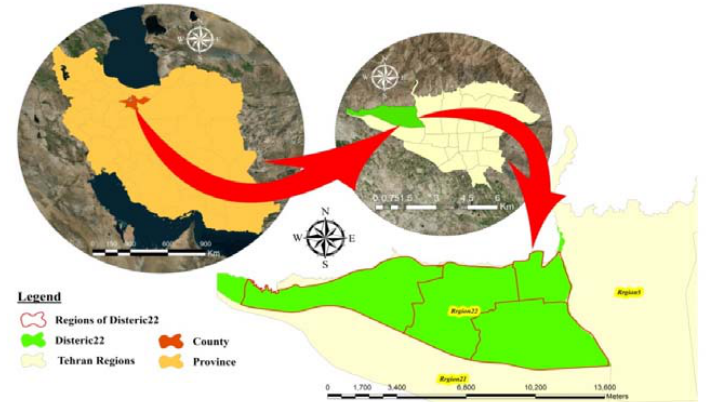
Fig. 2: District 22 of Tehran Municipality